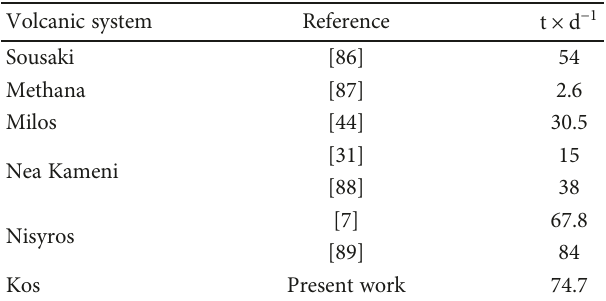
Table 4: CO output from the volcanic/geothermal systems along 2 the